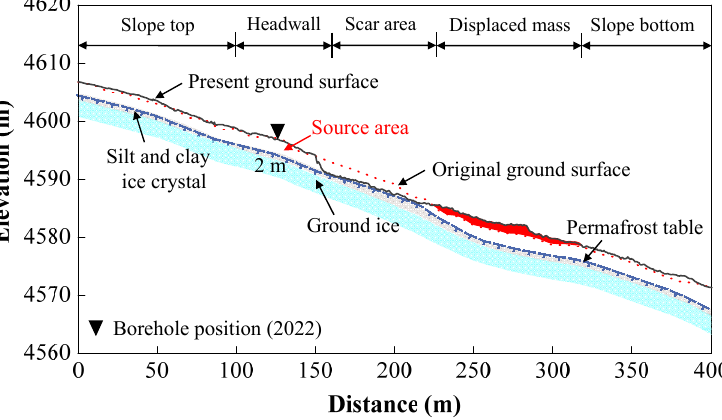
Figure 2. Longitudinal profile of the K1129W thaw slump.